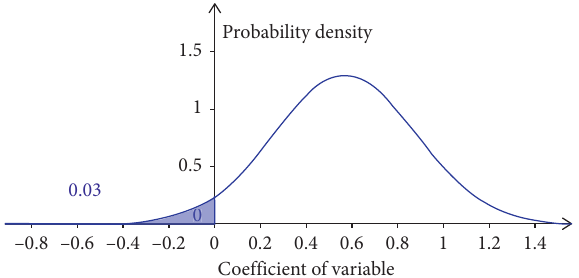
Figure 4: Varying effects of punctuality on passengers’ HSR choice.